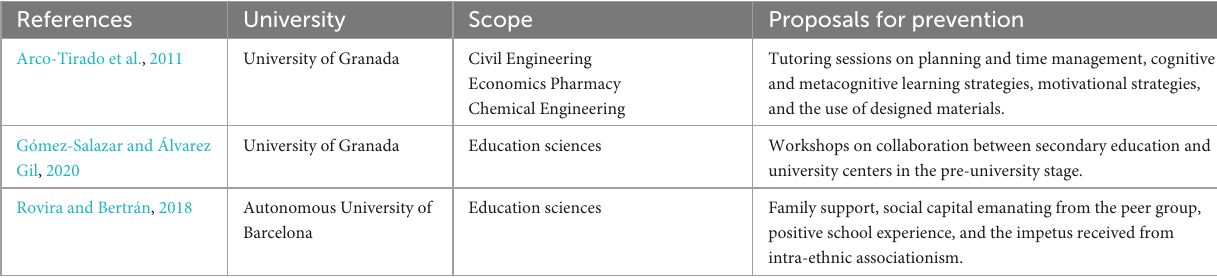
TABLE 7 Articles on proposals to prevent academic dropout in higher